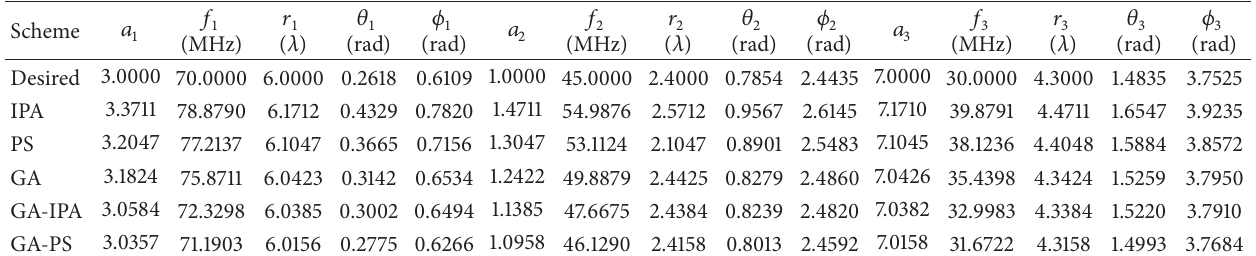
Table 5: Estimation accuracy for 3 sources at SNR = 5 dB.